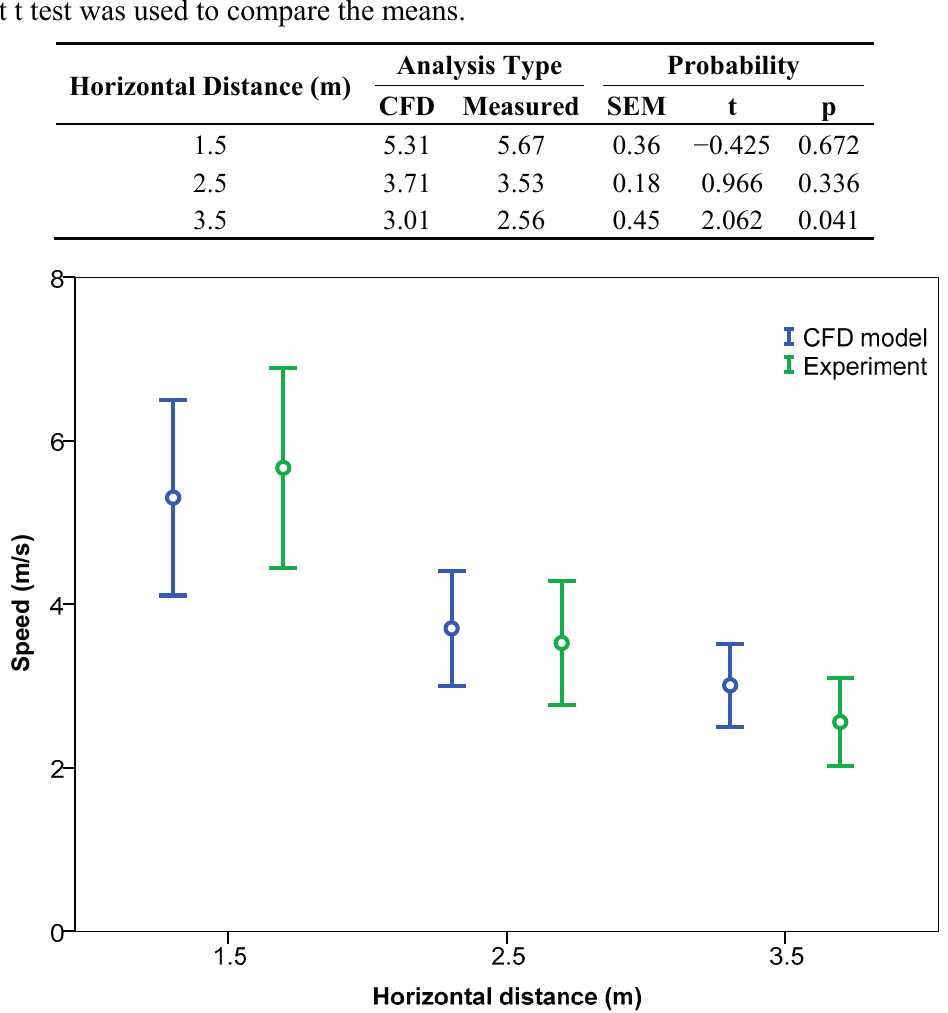
Figure 13. 95% confidence interval of means of air velocity values according to analysis type and horizontal distance.